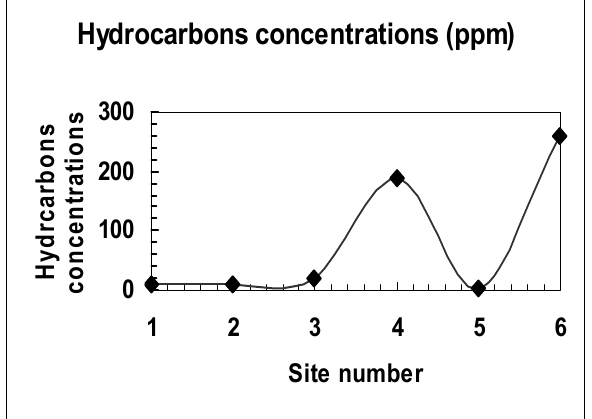
Figure 4: Variation of CO number. The line-diamonds are the experimental